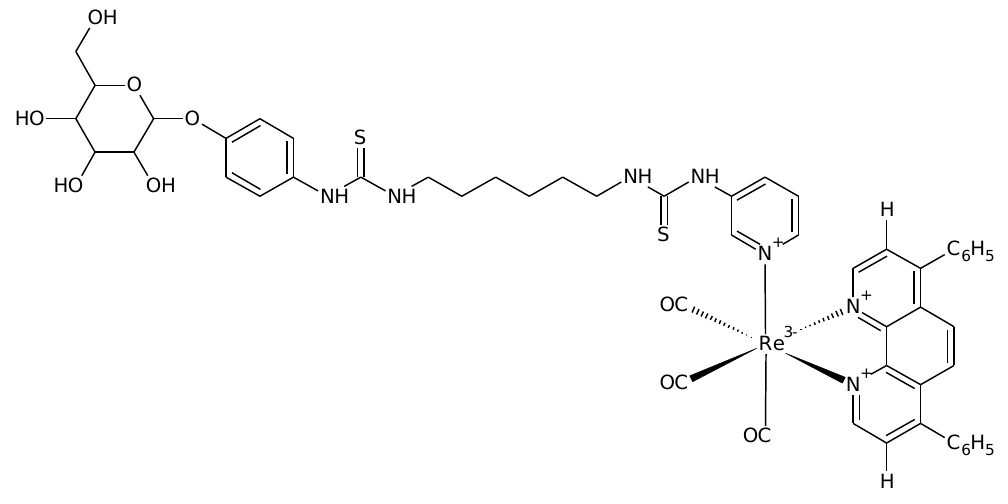
Figure 9. Chemical structure of the pyridine4,7-diphenyl-1,10-phenanthroline (Ph -phen)rhenium(I) polypyridine glucose complex, developed by the laboratory of 2 Professor Kenneth Kam-Wing Lo at the University of Hong